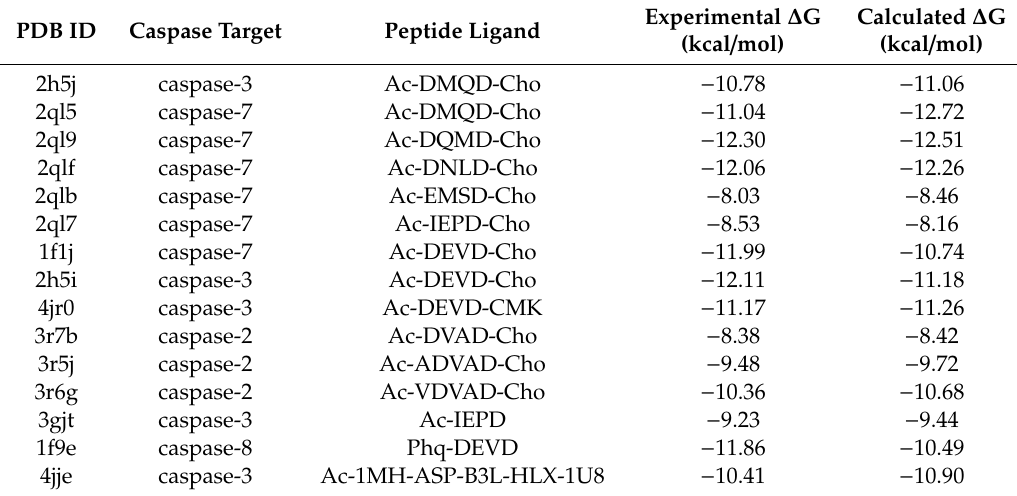
Table3. BindingfreeenergycalculationresultsbyusingtheMTprotocolagainstthecaspase-polypeptide complexing test